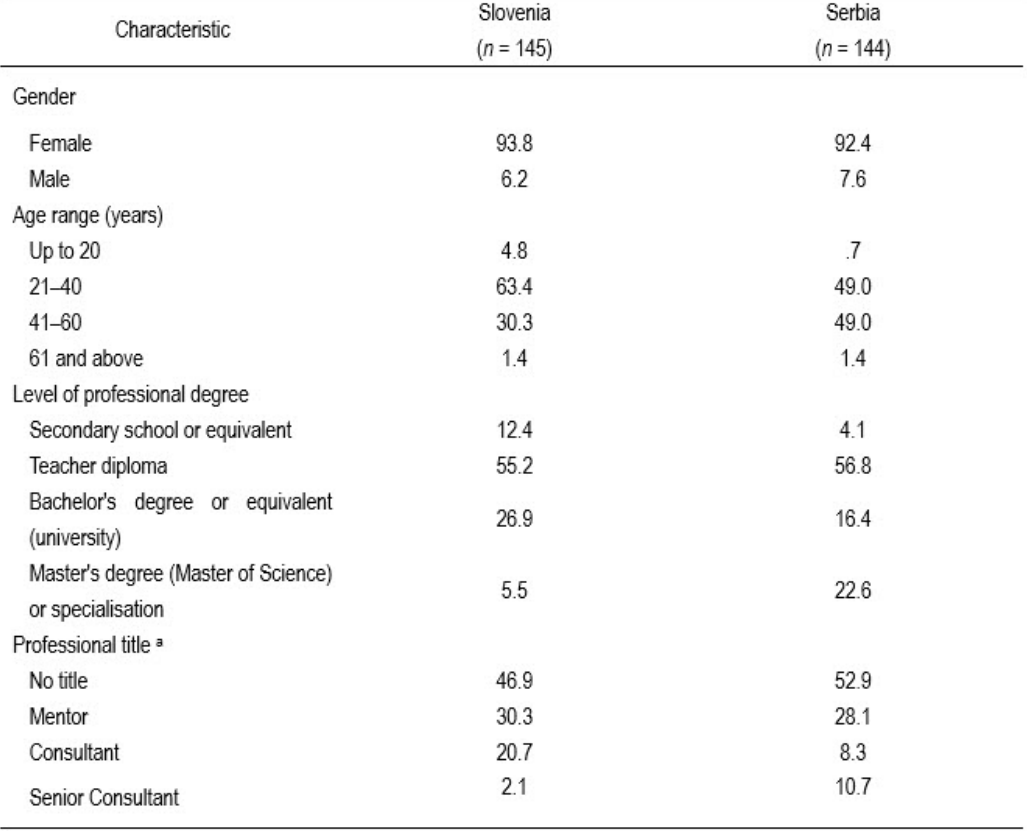
Demographic characteristics as a percentage of Slovenian and Serbian